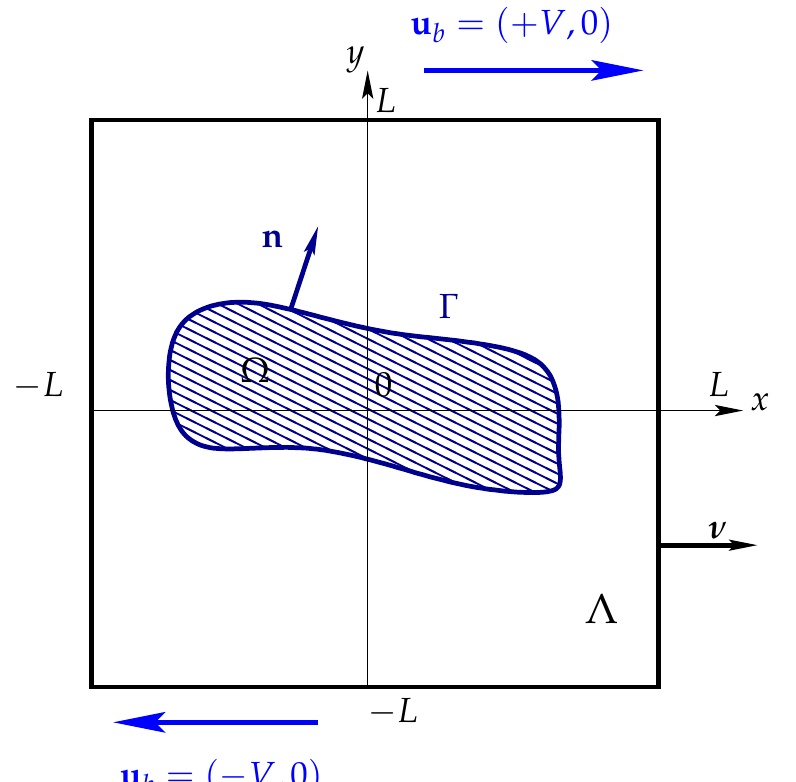
Figure 1. Representation of a vesicle Γ immersed a computational domain Λ under simple shear flow